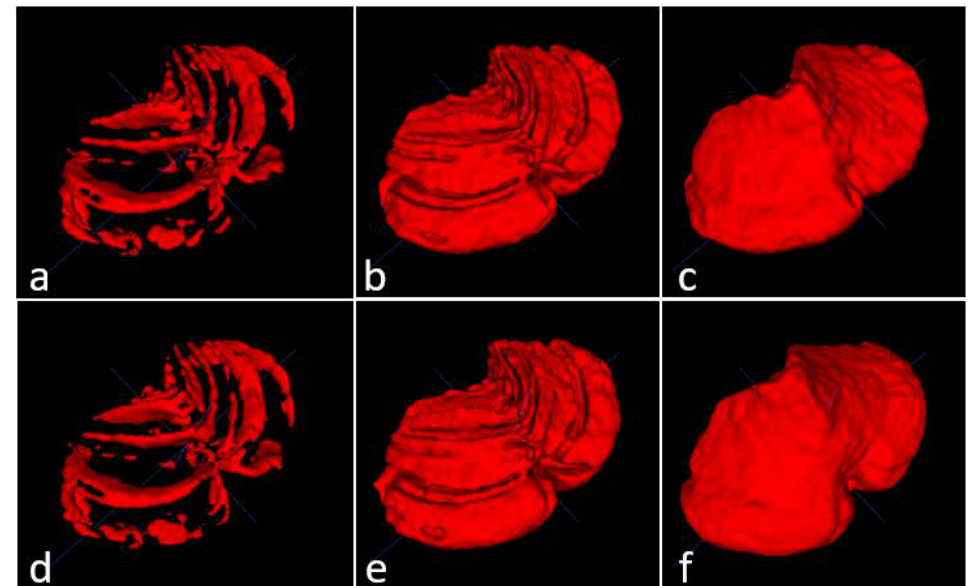
Figure 4. Masks and predictions for an MRI belonging to one of the SCA2 patients in the test subset. The top row shows the original masks, obtained with the procedure described in Section 2.2, and the bottom row displays the segmentations produced by our models. Cerebellar fissures in ( a , d ), cerebellum tissue with fissures in ( b , e ), and whole cerebellum without any fissure in ( c , f ). Produced segmentations have relatively good scores. Mean DSC and OC are 0.854